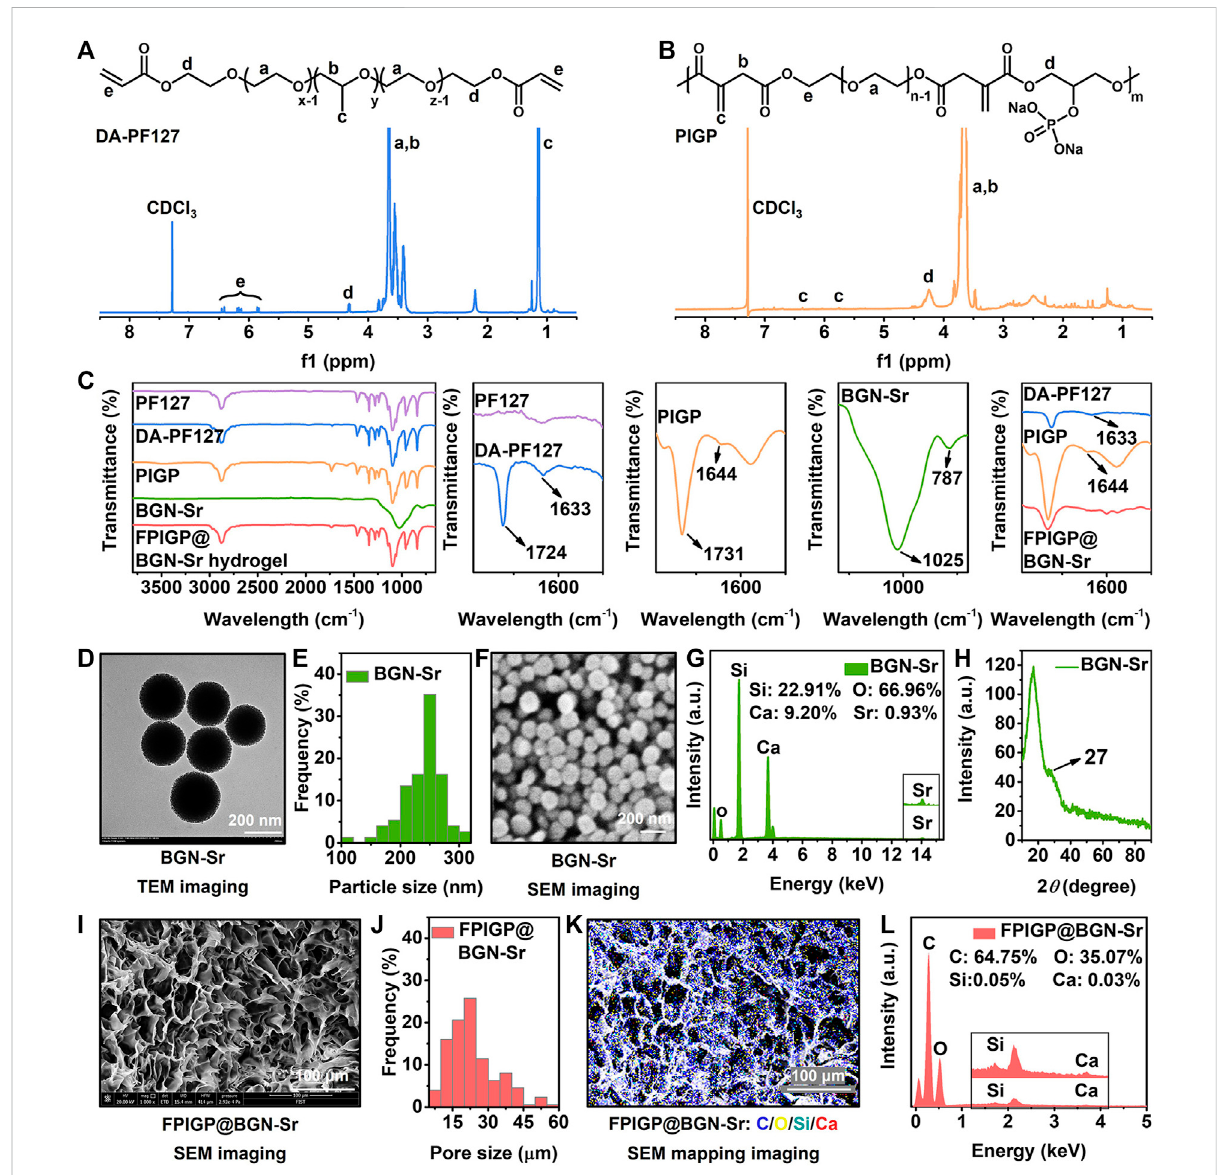
FIGURE 2 Physicochemical structures of polymers and hydrogels. (A , B) The 1 H NMR spectra of (A) DA-PF127 polymer and (B) PIGP polymer. (C) The FTIR spectra ofPF127,DA-PF127andPIGP polymer, BGN-Sr andFPIGP@BGN-Srhydrogel. (D) The TEMimageofBGN-Sr. (E) The particlesize ofBGN-Sr. (F) The SEM image of BGN-Sr. (G) The EDS spectrum of BGN-Sr. (H) The XRD pattern of BGN-Sr. (I) The SEM image of FPIGP@BGN-Sr hydrogel. (J) The pore size of FPIGP@BGN-Sr hydrogel. (K) The EDS mapping of FPIGP@BGN-Sr hydrogel. (L) The EDS spectrum of FPIGP@BGN-Sr